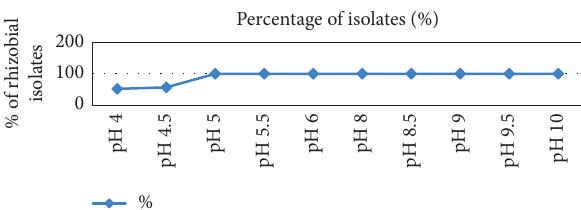
Figure 5: Tolerance of rhizobia isolates to different pH levels.